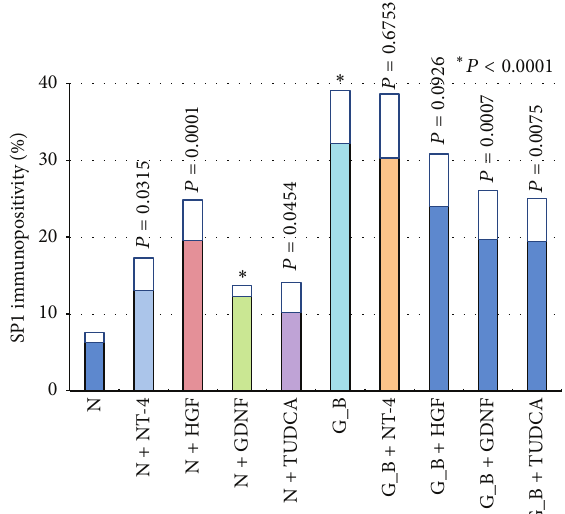
Figure 5: Graph showing the ratio of SP1 immunopositive cells to all cells in the GCL of retinal explants. N, serum free media, G B, glucose- AGE-BSA;Glycol,glycolaldehyde-AGE-BSA;Glycer,glyceraldehyde-AGE-BSA;NT-4,neurotrohin-4;HGF,hepatocytegrowthfactor,GDNF, glial cell line-derived neurotrophic factor; TUDCA, tauroursodeoxycholic acid.